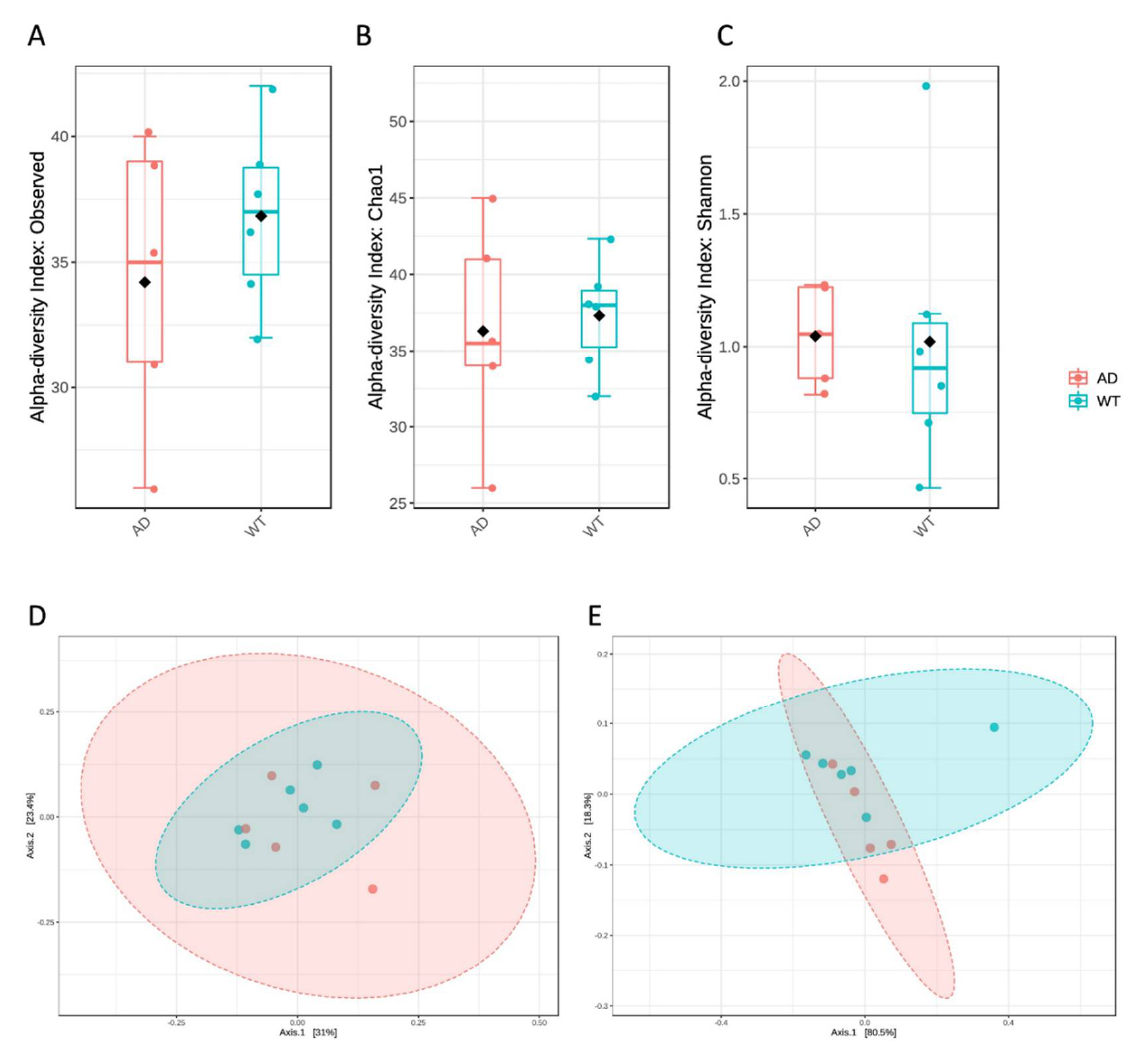
Figure 4. Diversity measures of the fungal taxa identified in the AD and WT mice. α diversity was calculated using observed species ( A ), Chao1 ( B ) and Shannon ( C ) indices. No significant differences were highlighted between the 2 tested conditions. β diversity was also measured using the unweighted ( D ) and weighted ( E ) UniFrac distance measures; in this case also, no significant differences were